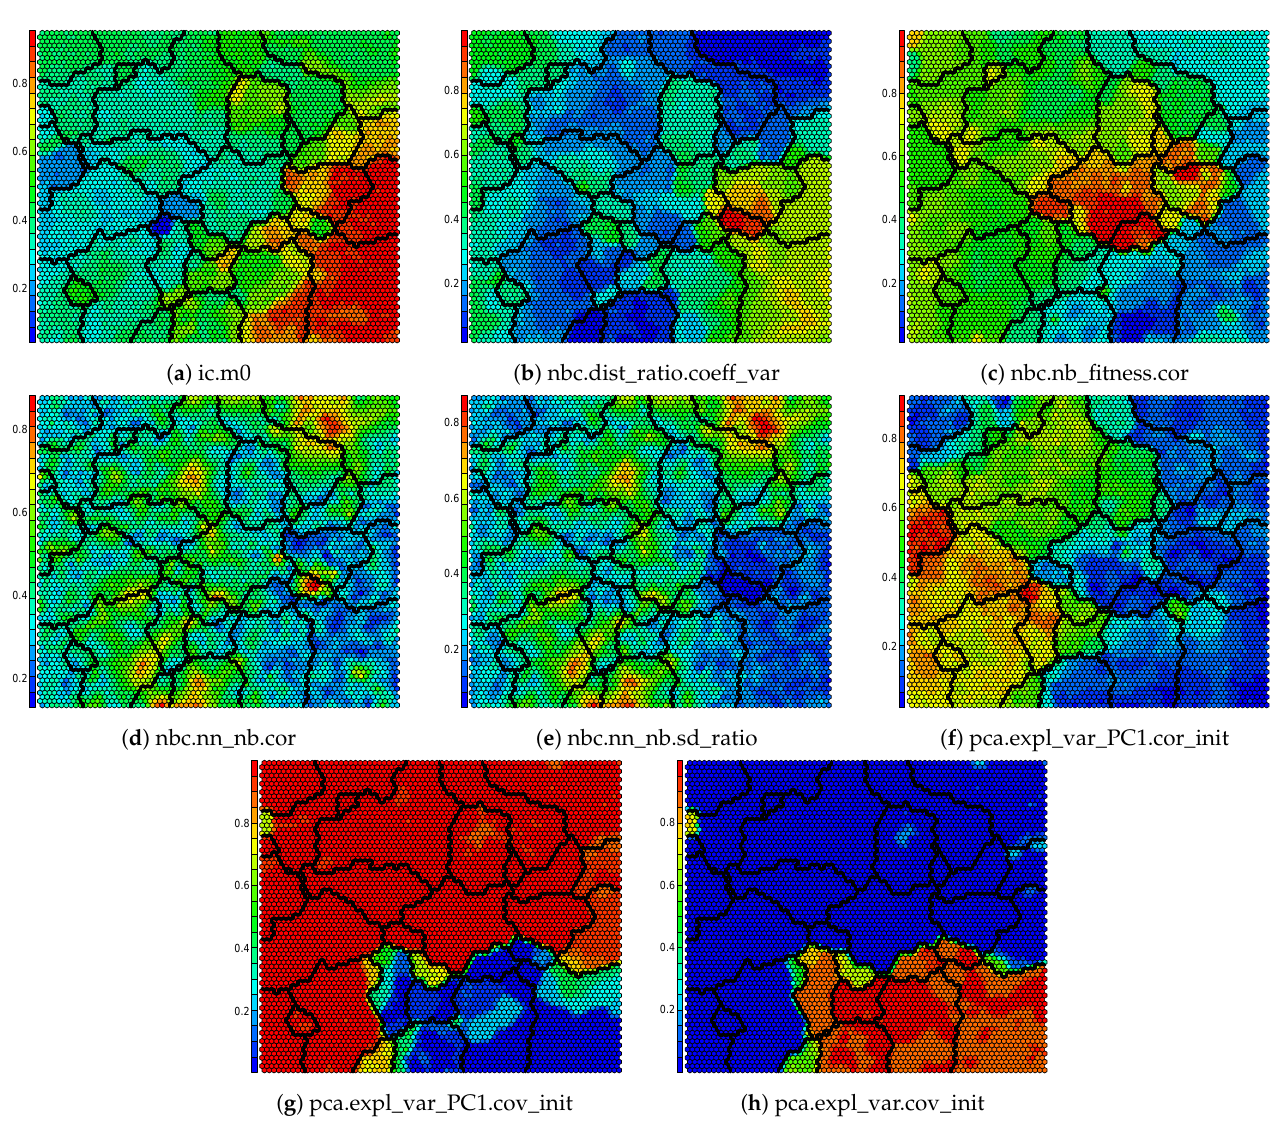
Figure A4. Normalized component maps from the clustered SOM